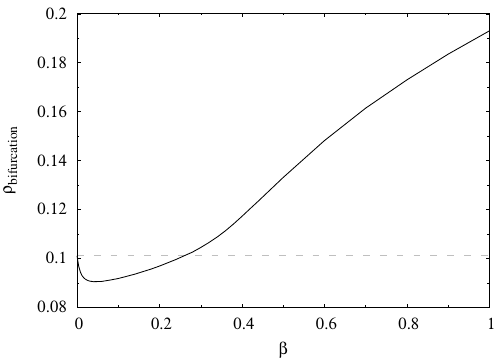
Figure 12 . The horizon radius at the bifurcation point (maximal BH that supports hair) as a function of the Skyrme-term coe(cid:14)cient (cid:12) . The minimum is around (cid:26) h = 0 : 04.